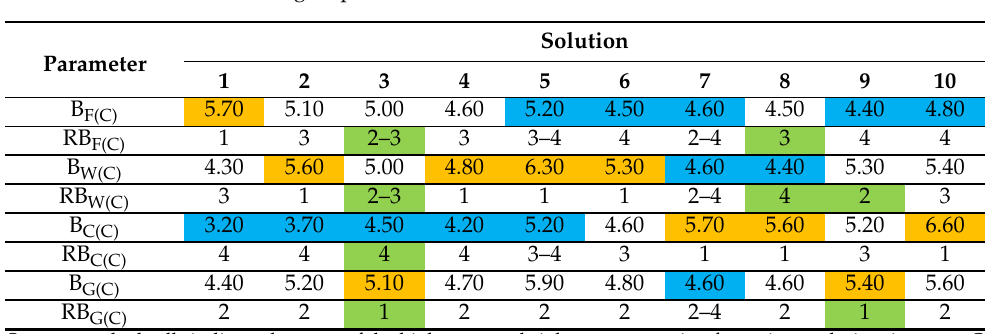
Table 6. Survey results and ranking of mean brightness perception levels of computer image of corridor for each solution, in group